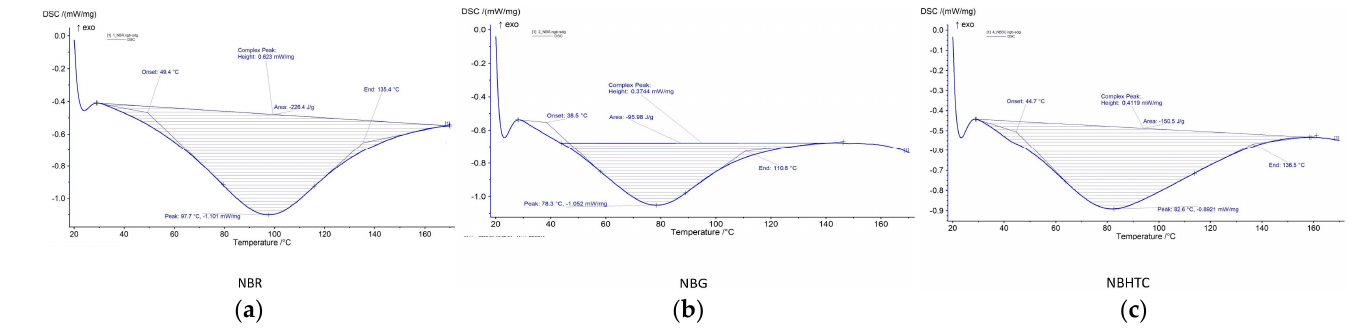
Figure 2. Thermal properties of raw ( a ), germinated ( b ), and hydrothermally cooked ( c ) Nitta bean